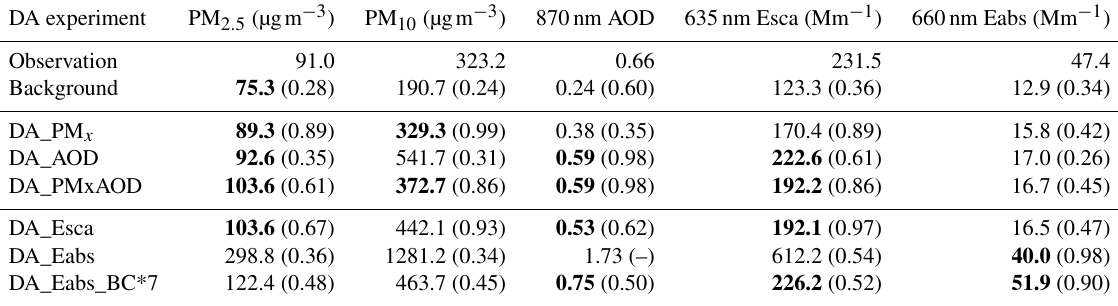
Table 2. The mean values of the PM 2 . 5 and PM 10 concentrations (µgm − 3 ), 635nm aerosol scattering coefficient (Esca, Mm − 1 ), 660nm aerosol absorption coefficient (Eabs, Mm − 1 ), and 870nm AOD in the background and analysis data and their correlation coefficients (in brackets) with the observations at 00:00, 06:00, 12:00, and 18:00UTC at Kashi in April 2019. The bold numbers denote the mean value that is not significantly different from the observation, and the line (–)denotes an insignificant correlation. Both the statistical tests of the mean difference and correlation are conducted at the significance level of